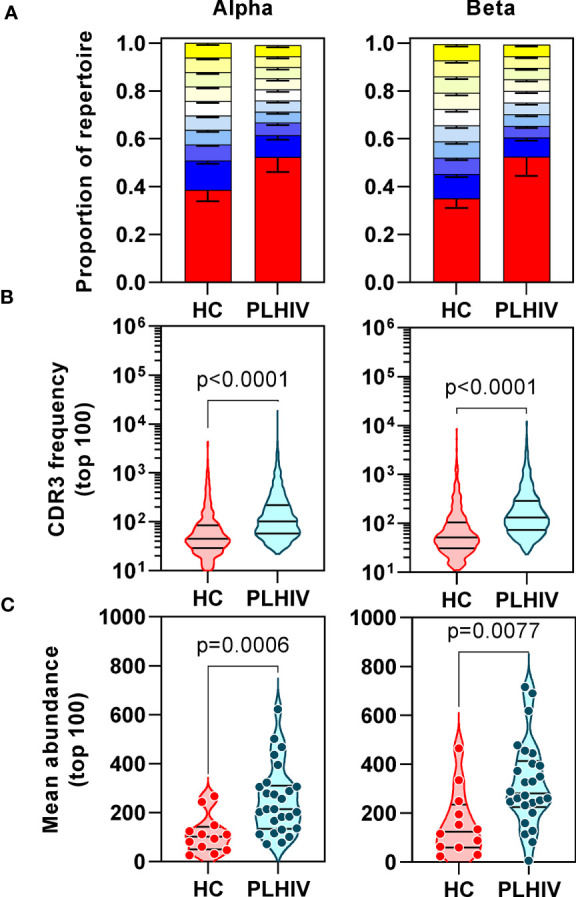
People living with HIV (PLHIV) show increased oligoclonal expansion of CDR3 sequences. (A) Frequency distribution of all CDR3 sequences, showing the proportion of the total repertoire that is occupied by each 10 percentile range of unique sequences. The percentile ranges are shown in decreasing order from the most abundant 10% (red) to the least abundant 10% (yellow at the top of each bar stack). Bars=median, error bars=interquartile range. (B) Frequency distribution of the 100 most abundant CDR3 sequences. (C) The mean abundance of the 100 most abundant CDR3 sequences in each individual.